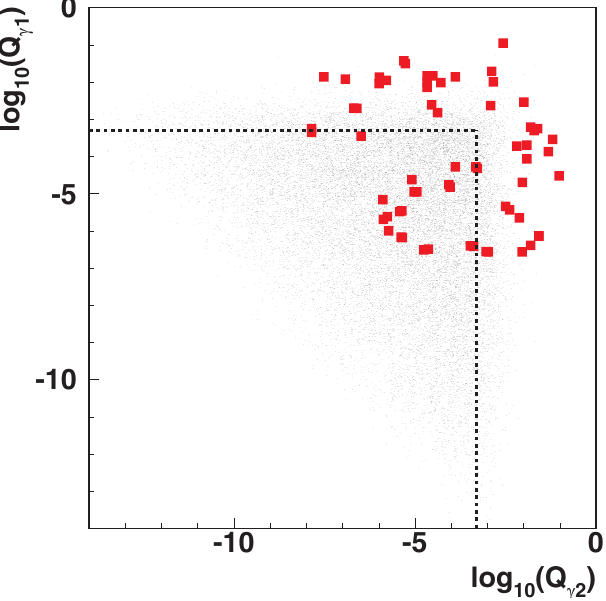
(cid:3) Q (cid:4) versus log (cid:3) Q (cid:4) in BDK simula- FIG. 10. (Color) log (cid:3) 1 (cid:3) 2 10 10 being in GeV. The highlighted points correspond to tion, Q (cid:3)i events with pair particles reaching the VD. The dashed lines indicate the position of the electron mass.